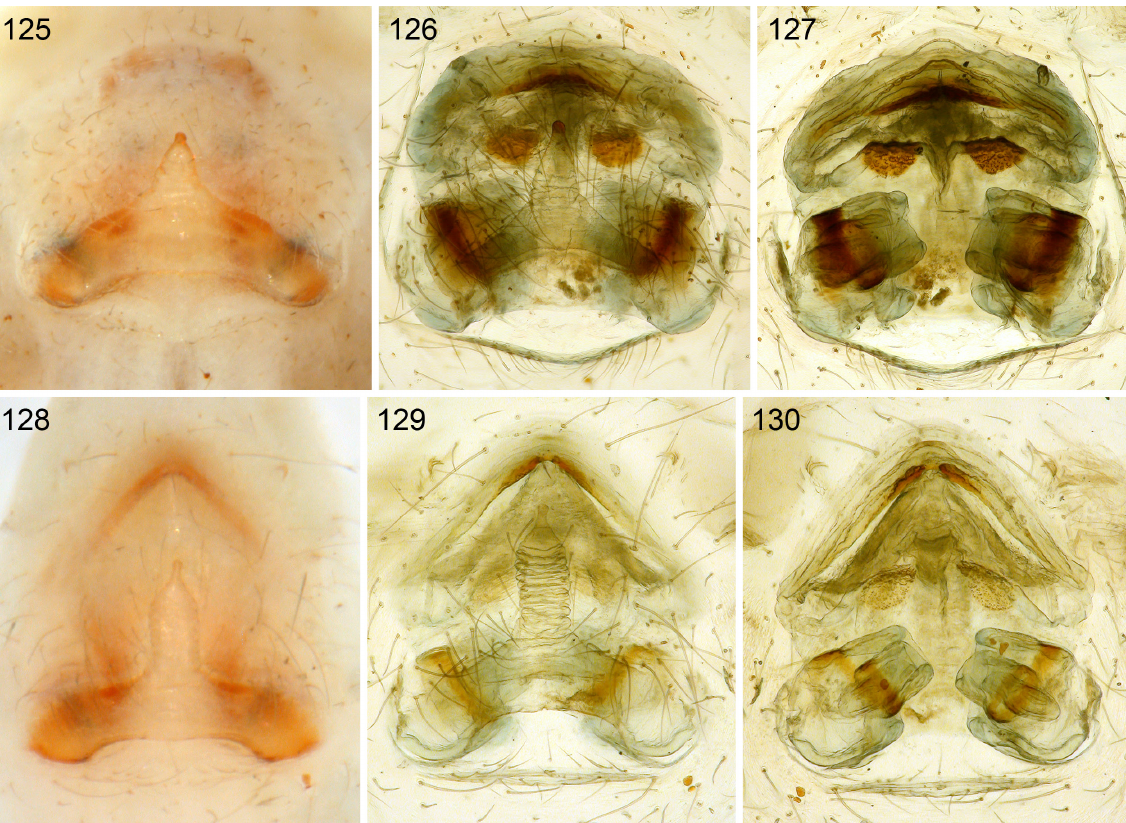
Figs 125–130. epigyna, ventral views, and cleared female genitalia, ventral and dorsal views. 125– 127 . Pholcus tambunan Huber sp. nov. (ZFMK, Ar 15712). 128–130 . P. bario Huber sp. nov. (ZFMK, Ar